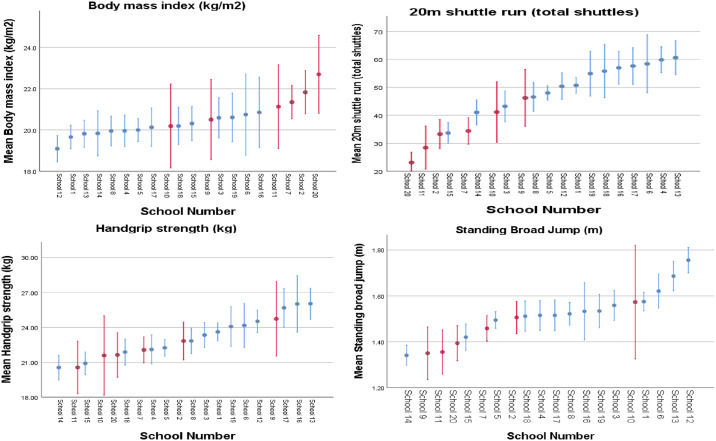
Clustered error bar mean graphs of 20 m shuttle run, body mass index, standing broad jump and handgrip strength tests with 95% confidence intervals, by school.Designated disadvantaged schools are highlighted red, non-disadvantaged schools are highlighted blue.